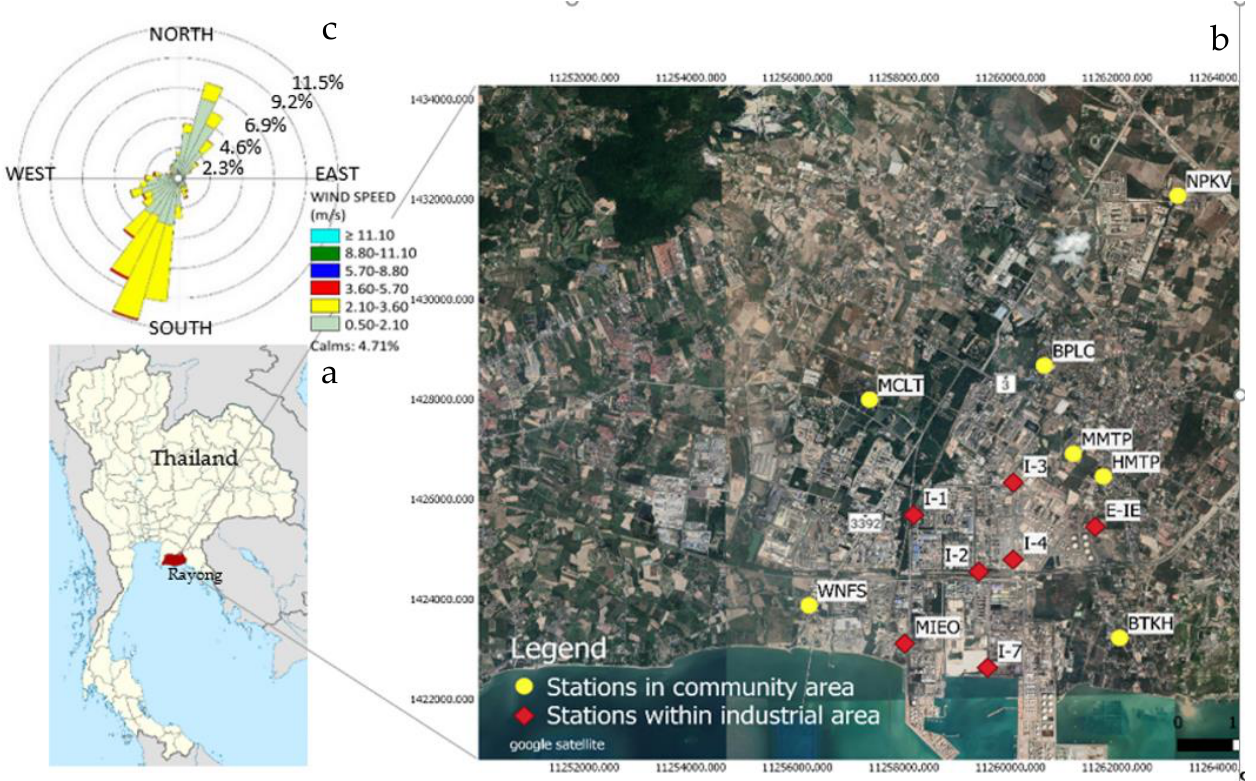
Figure 1. Location of Map Tha Phut industrial complex, Rayong, Thailand ( a ) and VOC monitoring stations ( b ) along with wind rose diagram ( c ). Table 1. Information on site characteristics in the community areas.